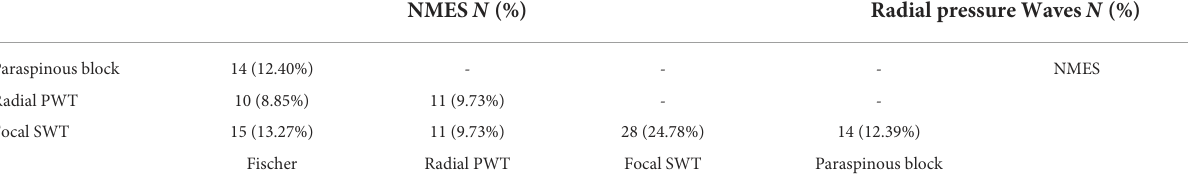
TABLE 3 Treatment